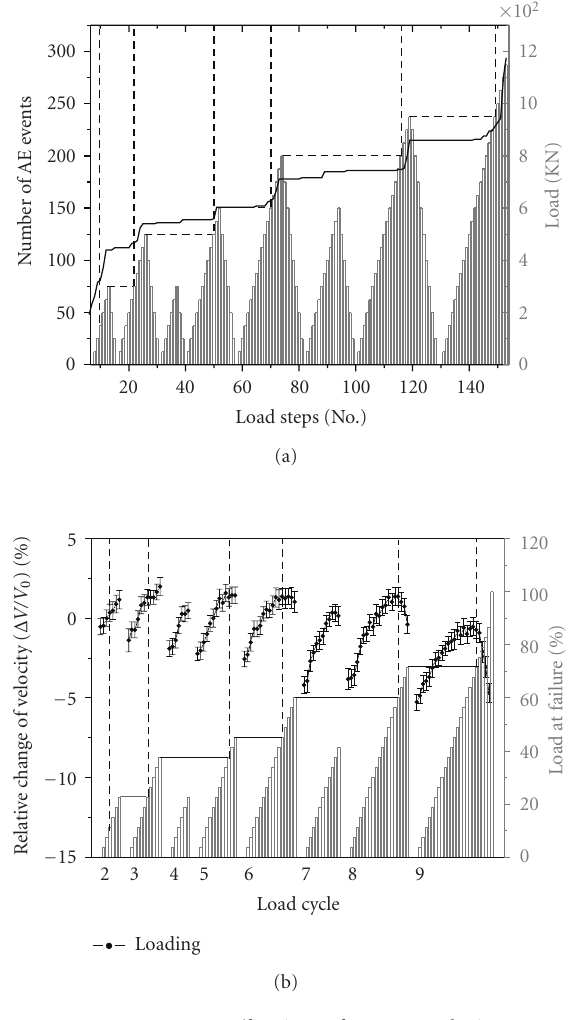
Figure 5: Stress memory e ff ect in surface wave velocity measure- ments: (a) AE test results and (b) surface wave velocities measured during load cycles 2 to 9. The second axs in both (a) and (b) indicate the level of loading in KN and as a percentage of the final load at failure, respectively. The results of the first load cycle are not included in these illustrations.